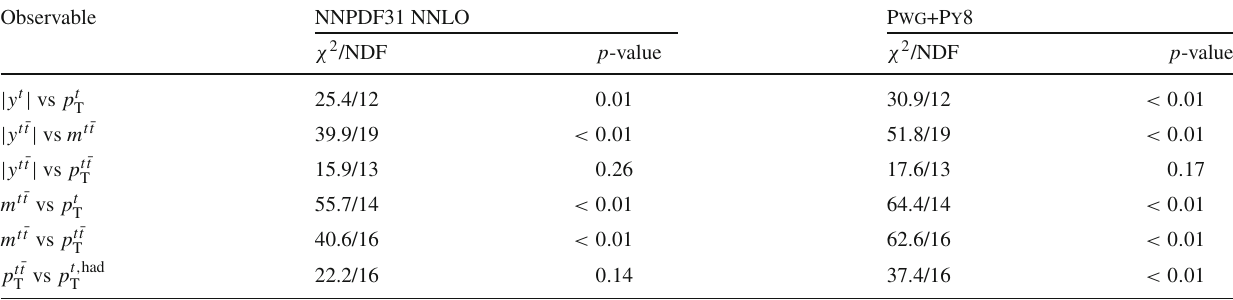
Table23 Comparisonofthemeasuredparton-levelnormaliseddouble- differential cross-sections in the resolved topology with the NNLO pre- dictions and the nominal Powheg + Pythia8 predictions. For each pre-